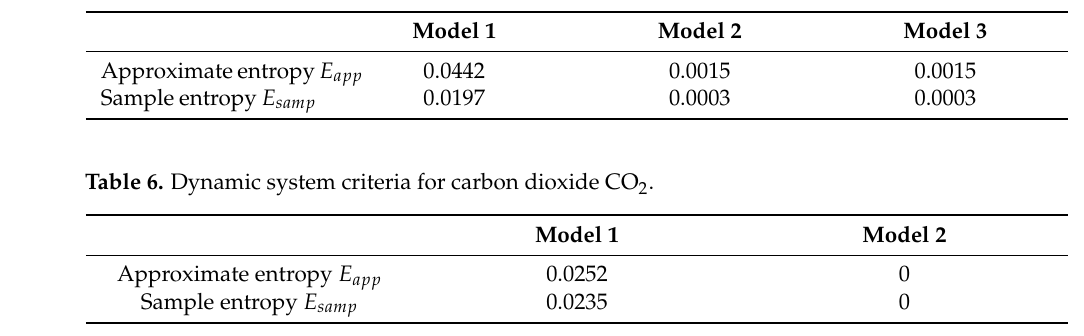
Table 5. Dynamic system criteria for hydrogen H 2 .